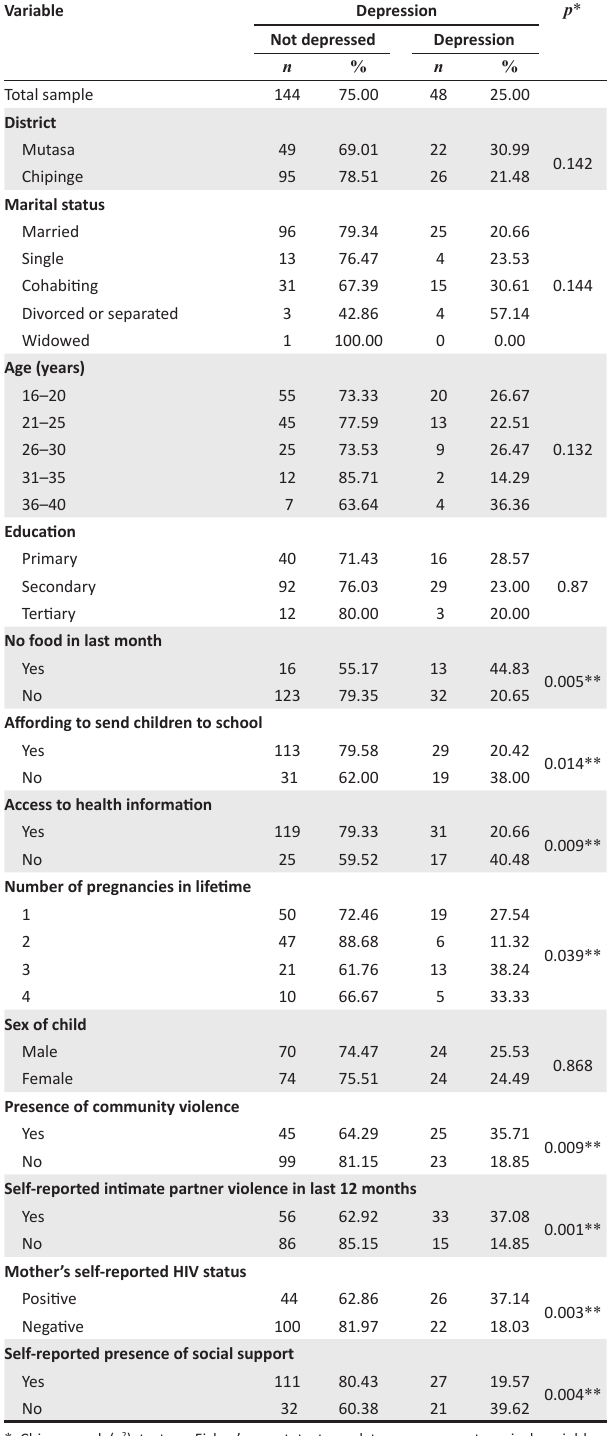
TABLE 2: Prevalence of postnatal depression by category among participants ( N = 192). Variable